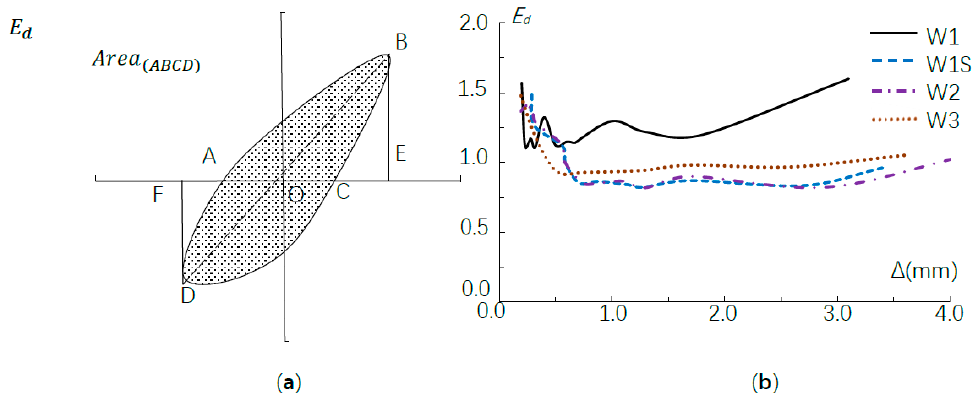
Figure 11. Energy dissipation coefficients ( E d ) of the walls: ( a ) Calculation of the energy dissipation coefficient; ( b ) energy dissipation coefficients of the walls.